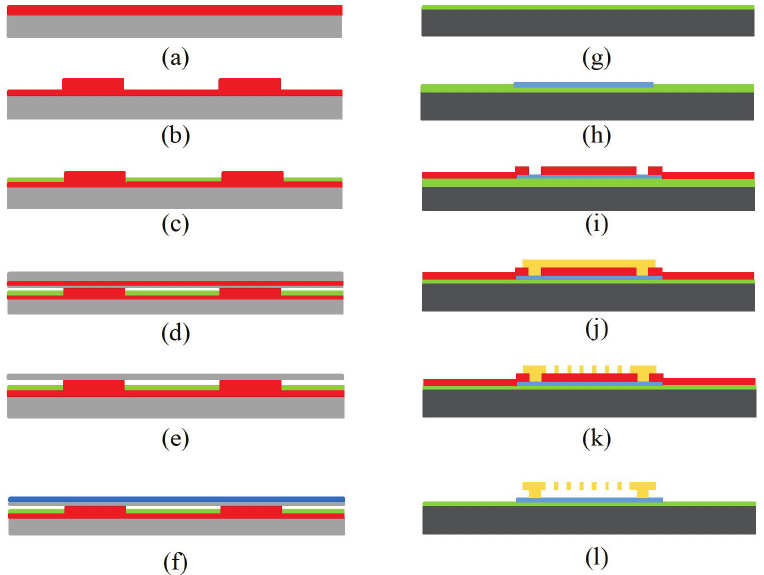
Figure 11. Schematic view of CMUT fabrication process using fusion bonding methods (( a ) wet oxidation of a highly doped silicon substrate followed by a lithography step, ( b ) growing SiO 2 by wet oxidation to further raise the bottom electrode, ( c ) oxide etch followed by the thermal oxidation of a thin SiO 2 , deposition of Si 3 N 4 , patterning and etching, ( d ) local oxidation to create anchors, ( e ) wafer bonding SOI wafer in vacuum followed by annealing, ( f ) removing carrier wafer and buried oxide layer) as well as sacrificial technique (( g ) deposition of Si 3 N 4 insulation layer, ( h ) deposition of polysilicon bottom electrode, ( i ) deposition of SiO 2 sacrificial layer followed by lithography patterning, ( j ) deposition of the top membrane polysilicon layer, ( k ) patterning top membrane to create sacrificial release holes, ( l ) release of the top membrane using wet